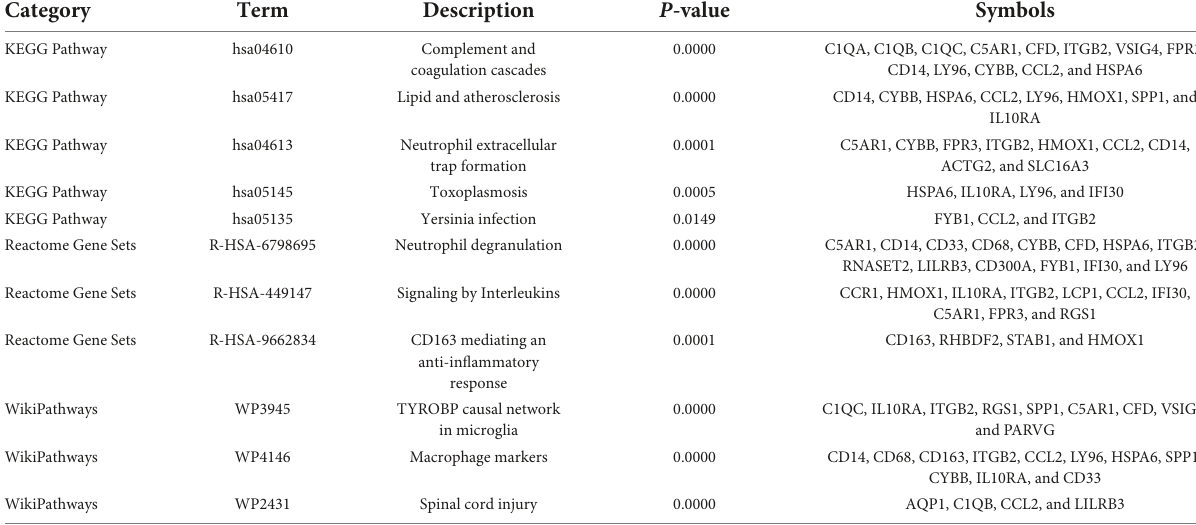
TABLE 3 Significantly enriched pathways of the overlapping differentially expressed genes (DEGs) between vascular dementia (VaD) and carotid atherosclerotic plaques datasets. Category Term Description P -value